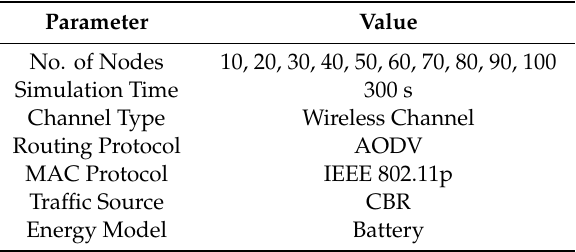
Table 4. Parameters for fog experiments.